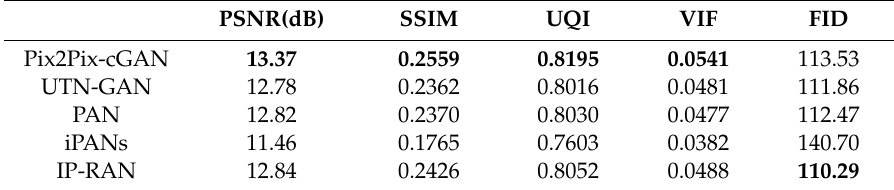
Table 4. Quantitative results of labels to architectural photos, bold results show good scores.